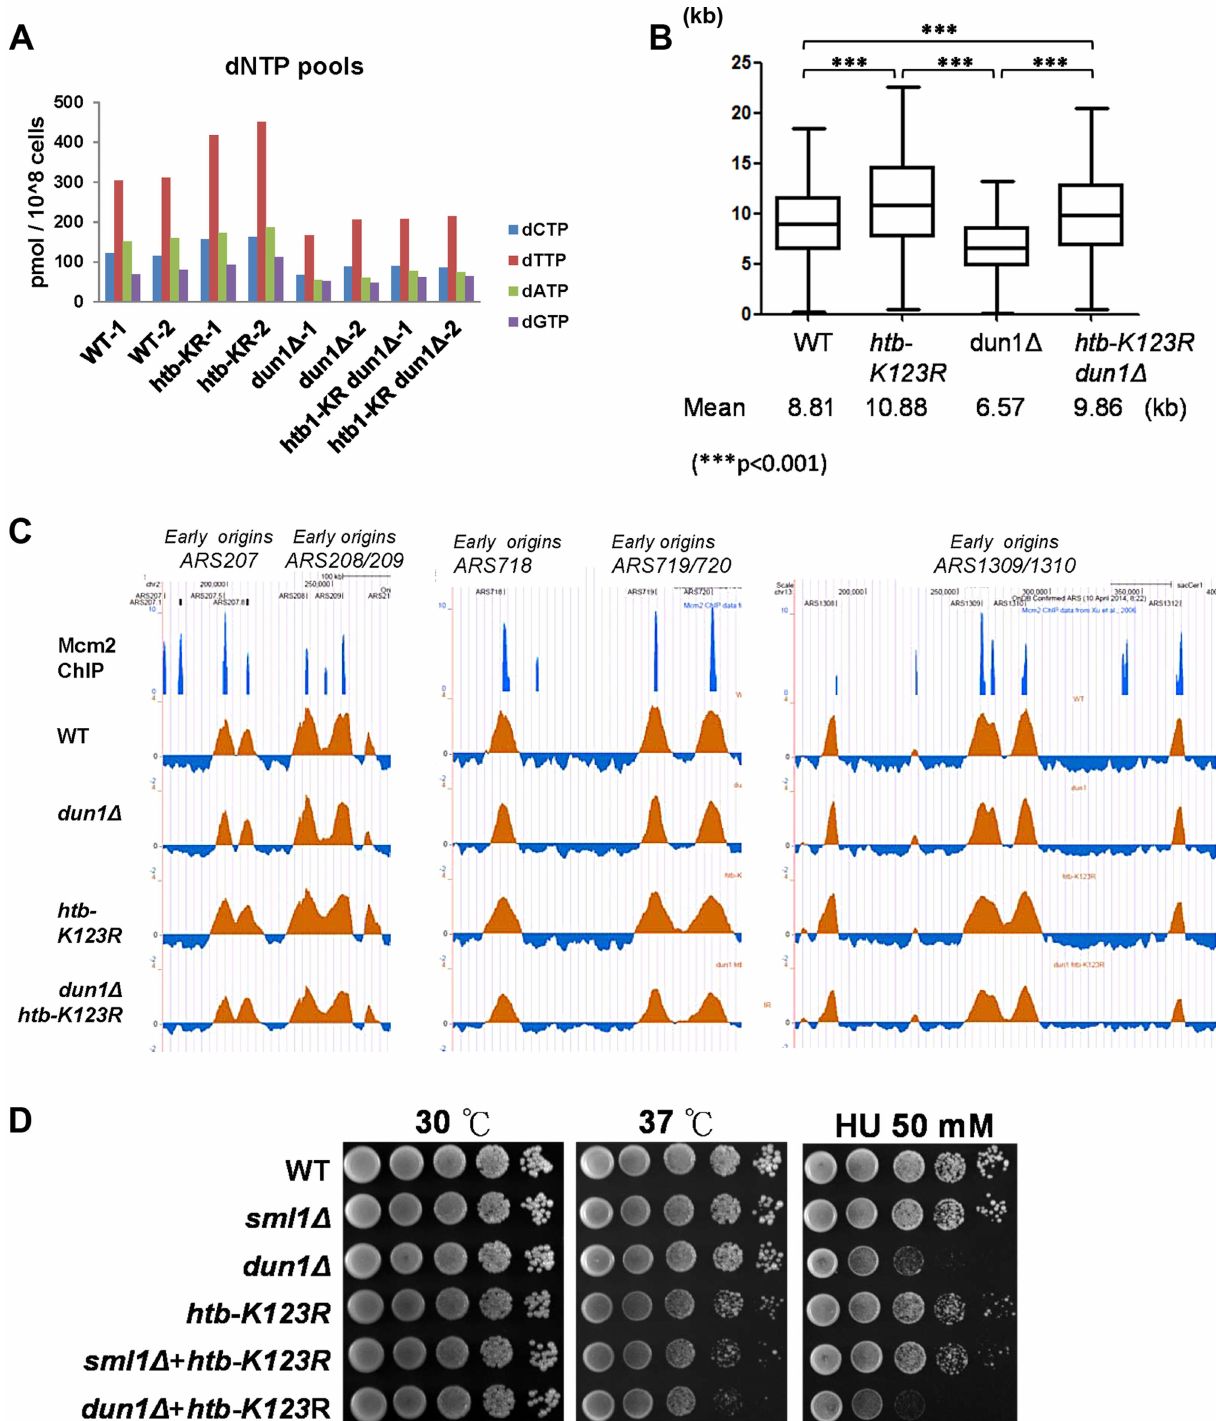
Figure 2. H2Bub-mediated fork stalling is independent of dNTP pool size. The size of the dNTP pools in exponentially-growing cultures of WT (CFK1419), htb-K123R (CFK1421), dun1 D (YCL023), and dun1 D htb-K123R (YCL025) cells in YPD media. Two independent isogenic strains of each genotype were analyzed. (B) Graph depicting the distribution of BrdU track lengths in WT (CFK1419), htb-K123R (CFK1421), dun1 D (YCL023), and dun1 D htb-K123R (YCL025) mutants, as shown in Fig. 1F. (C) Replication profiles of the replication origins ARS207 , ARS208/209 , ARS718 , ARS719/720 , and ARS1309/1310 in WT (CFK1419), htb-K123R (CFK1421), dun1 D (YCL023), and dun1 D htb-K123R (YCL025) mutants. The BrdU histogram was analyzed as described in Fig. 1C–E. (D) Temperature sensitivity and HU resistance of the indicated genotypes (WT (CFK1204), sml1 D (CFK1481), dun1 D (YMW069), htb-K123R (CFK1231), and htb-K123R in combination with sml1 D (CFK1482) or dun1 D (YMW072)). Log-phase cells were serially diluted and spotted onto YPD plates with or without HU, and incubated at 30 u C or 37 u C for 2–3 days.